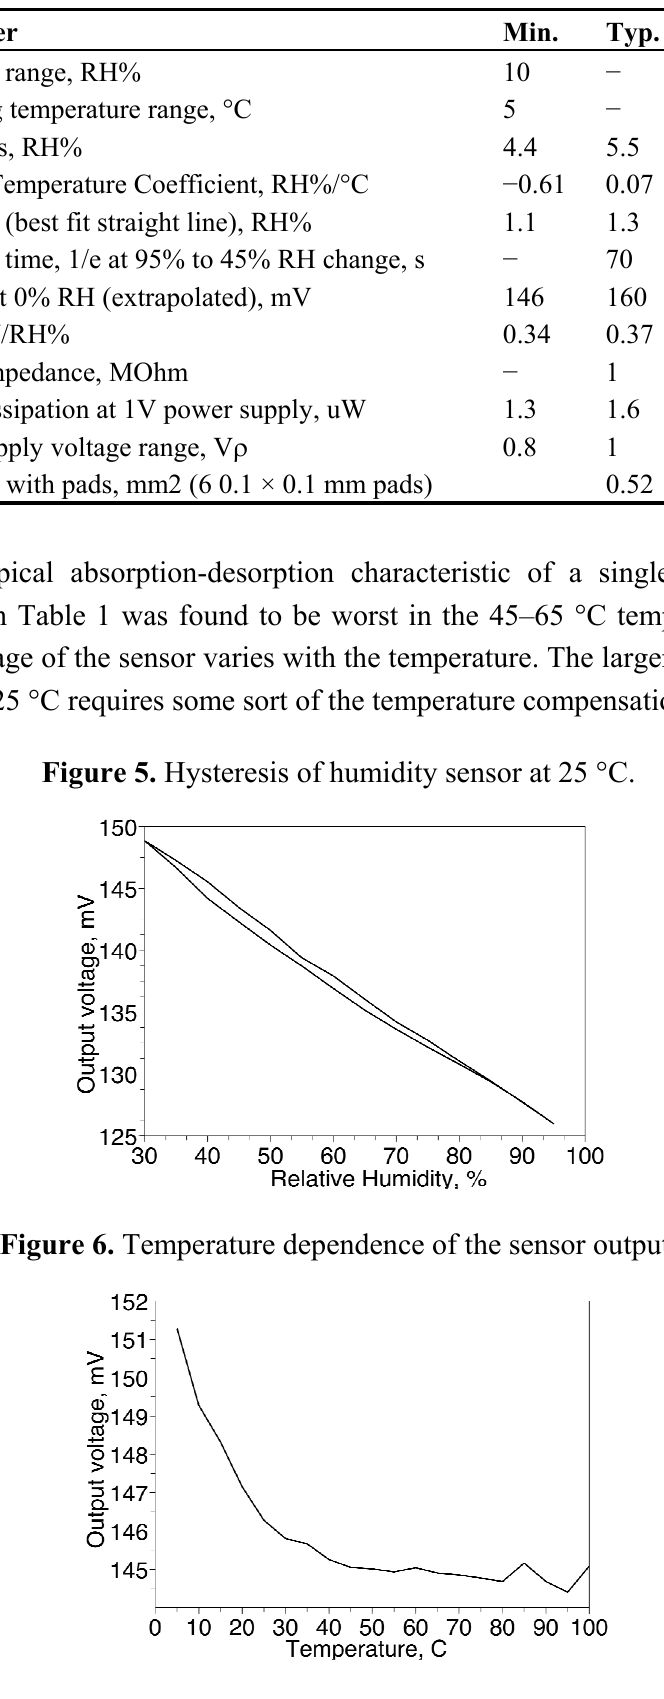
Table 1. Performance Summary 1st Batch of five Humidity Sensors.